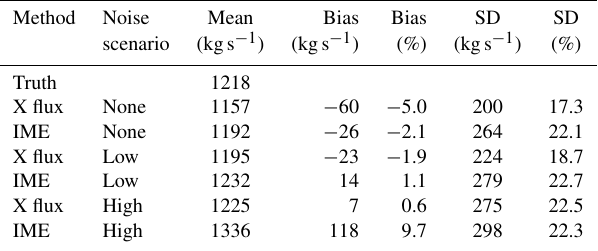
Table 5. Emissions from the Bełchatów power plant estimated with the cross-sectional flux (X Flux) and integrated mass enhancement (IME) methods. Results are presented for 09:00–15:00UTC aver- aged fluxes from eight different models, as shown in Fig. 15, for a low and a high CO2M measurement noise